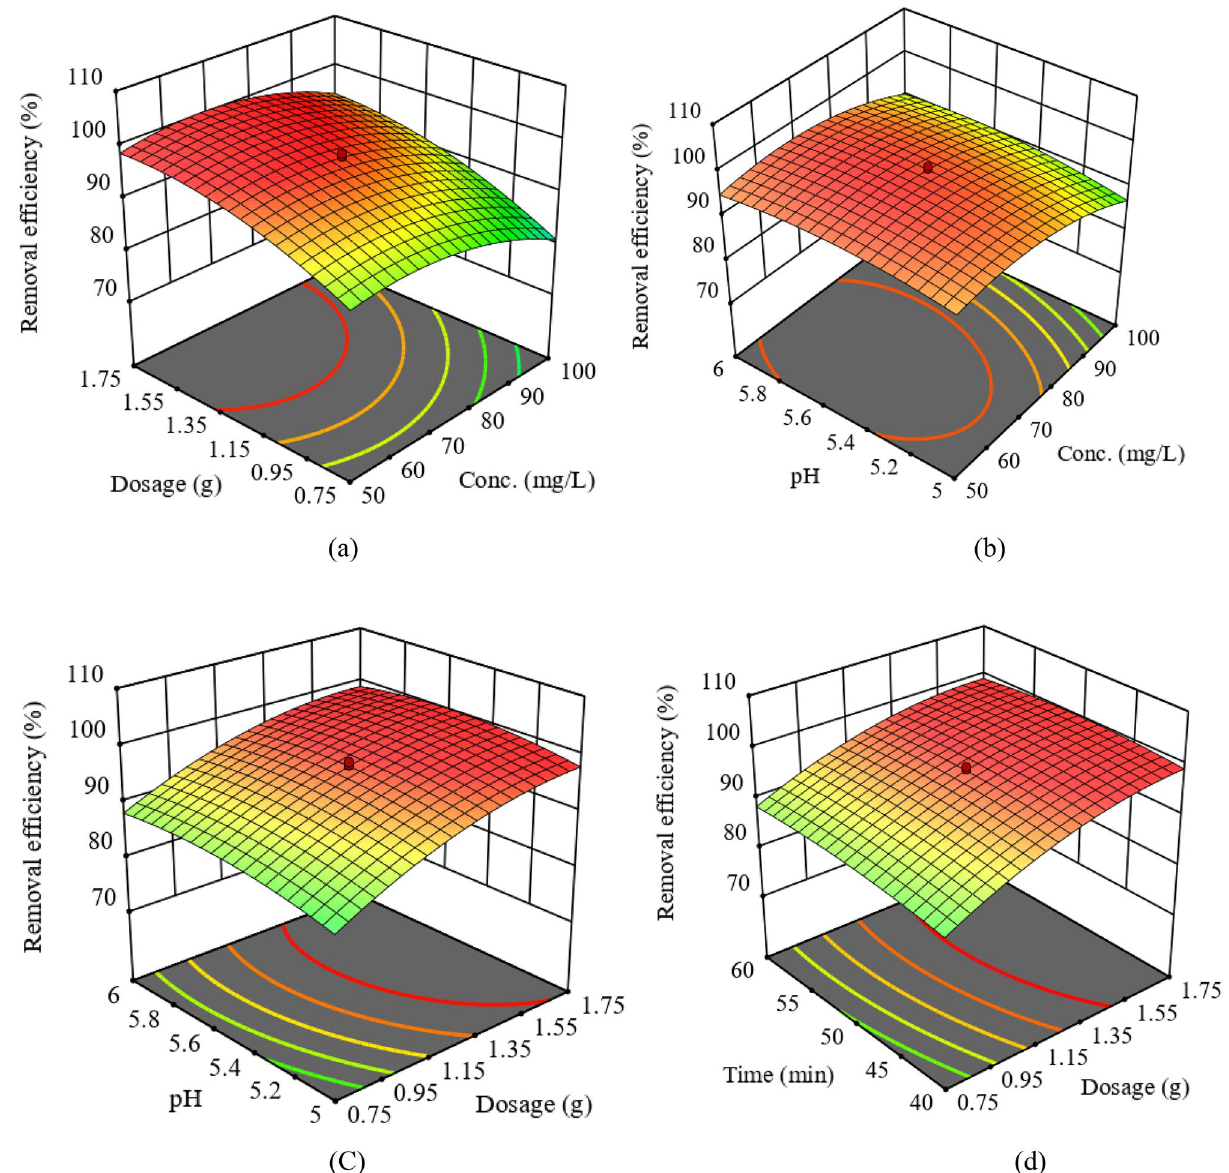
Figure 6. Interactive effect of parameters on the removal efficiency of Cd (II) ( a ) initial Cd concentration versus adsorbent dosage, ( b ) initial Cd concentration versus pH, ( c ) adsorbent dosage versus solution pH, and ( d ) adsorbent dosage versus contact